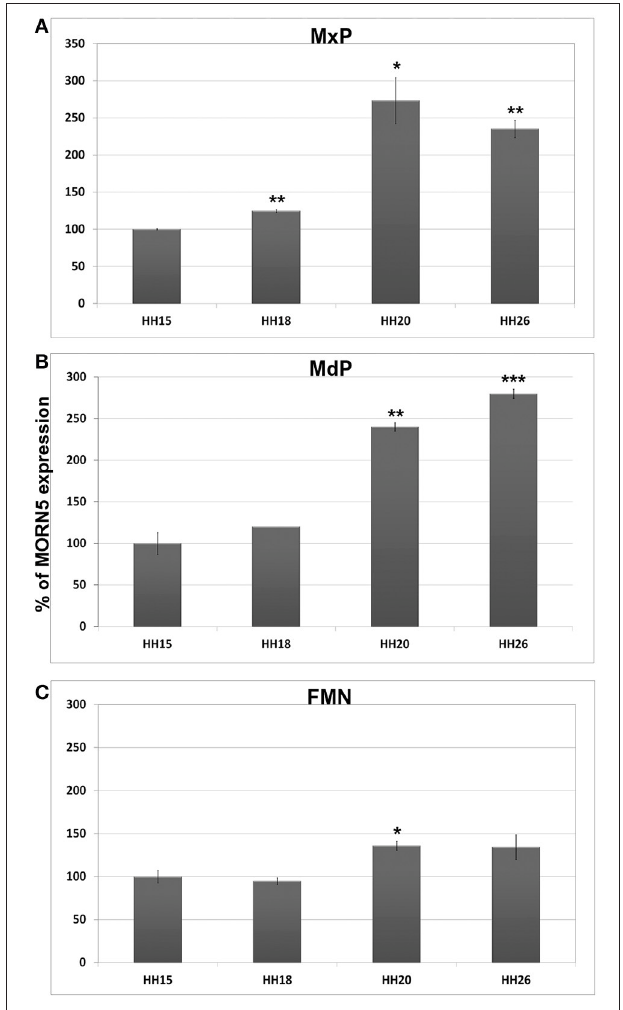
FIGURE 5 | QPCR analysis of MORN5 expression during face development. (A) In the maxillary prominence, there was most prominent expression at stage HH20. All analyzed stages showed statistically significant overexpression in comparison to stage HH15. (B) In the mandibular prominence, we observed significant expression at stage HH20 and 26. (C) Very low MORN5 expression was detected in the frontonasal mass at stage HH15 and 18, but at stage HH20 was MORN5 expression significantly increased. FNM, frontonasal mass; MdP, mandibular prominence; MxP, maxillary prominence. t -test; *** p < 0.001, **0.001 < p < 0.01, * p <